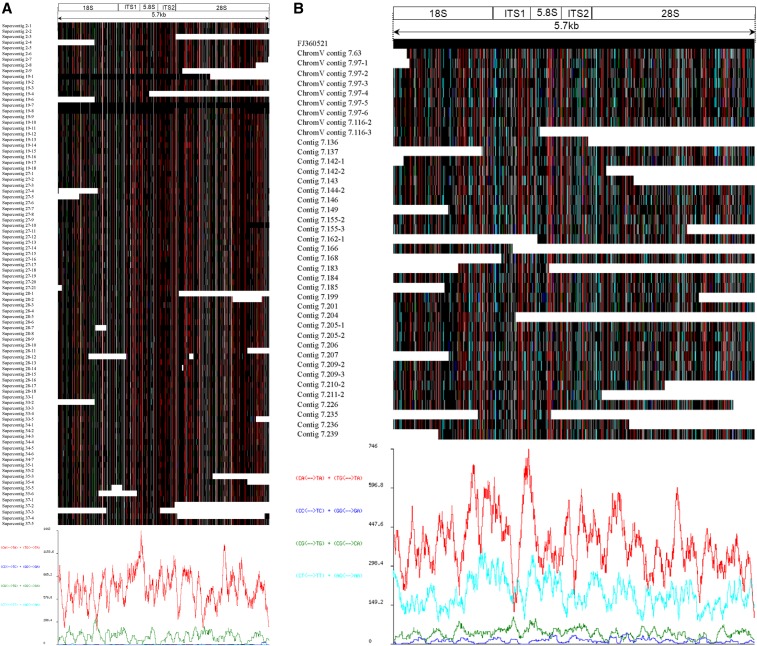
RIP mutation in rDNA units of (A) L. maculans and (B) N. crassa shown as RIPCAL output. Functional rDNA sequences, i.e., supercontig 19-7 of L. maculans and FJ360521 of N. crassa were defined as consensus. Black, invariant nucleotide; white, gap; red, CpA ↔ TpA or TpG ↔ TpA mutations; dark blue, CpC ↔ TpC or GpG ↔ GpA mutations; green, CpG ↔ TpG or CpG ↔ CpA mutations; pale blue, CpT ↔ TpT or ApG ↔ ApA mutations.